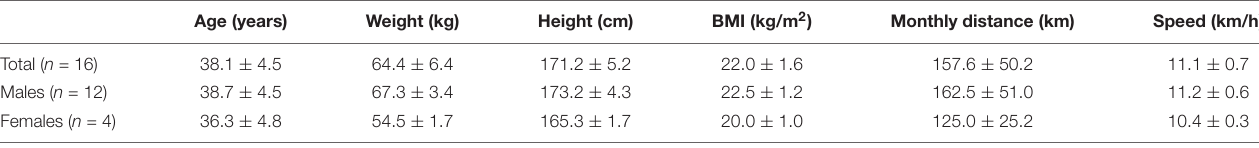
TABLE 1 | Participant and race characteristics of the 16 half-marathon